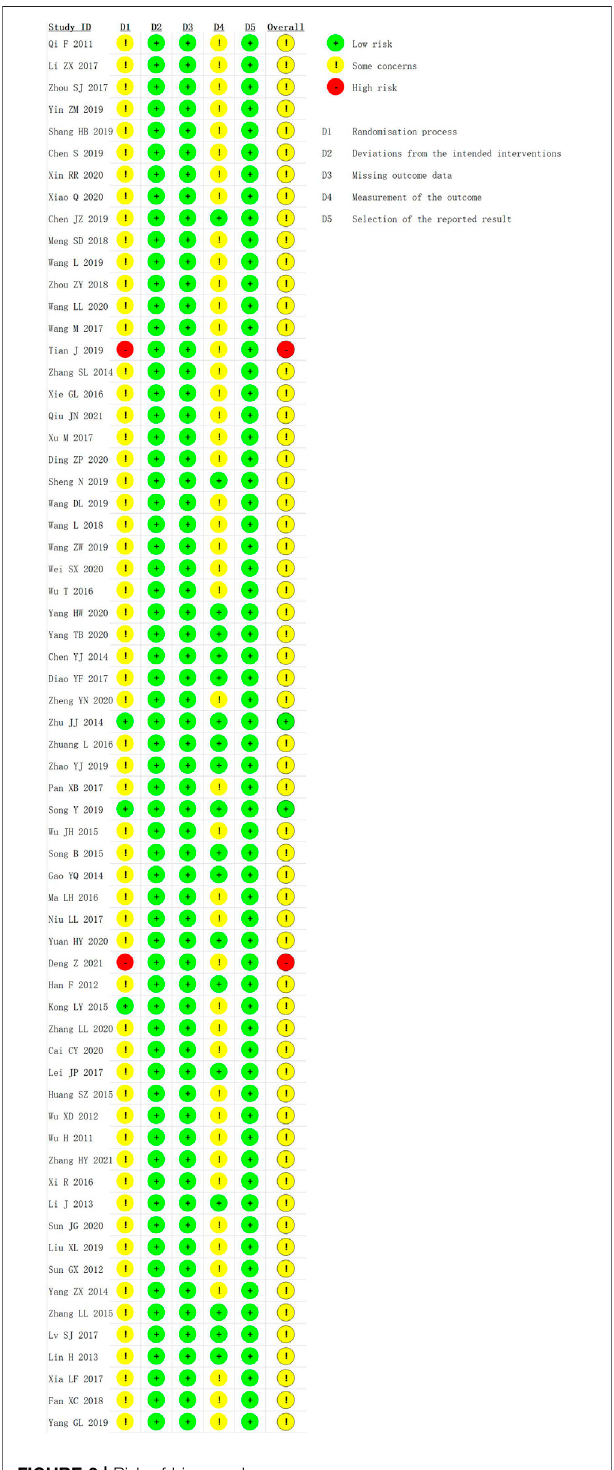
FIGURE 3 | Risk-of-bias